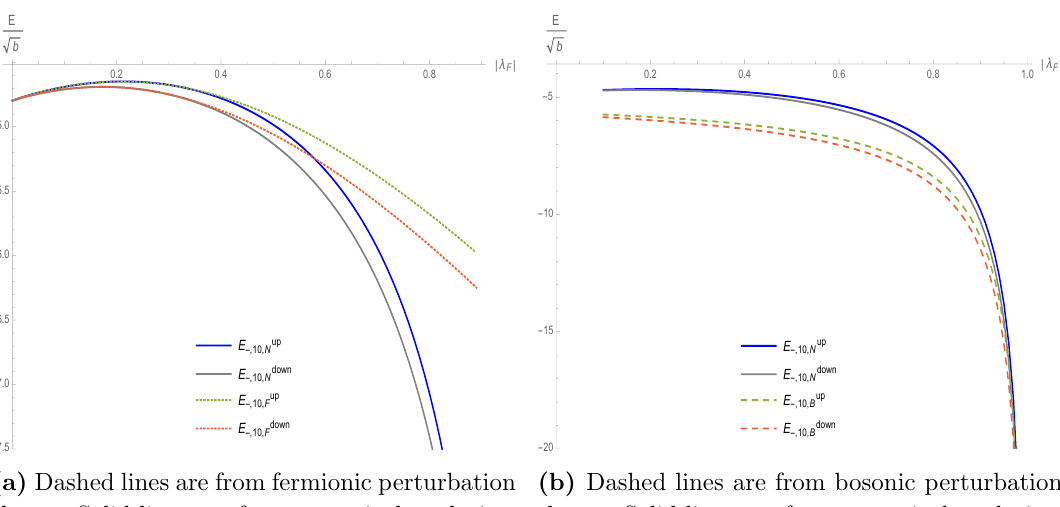
(a) Dashed lines are from fermionic perturbation (b) Dashed lines are from bosonic perturbation theory. Solid lines are from numerical analysis. theory. Solid lines are from numerical analysis. Figure 4. Critical chemical potentials for the M = 10 negative energy band as a function of (cid:21) F p for sgn(b (cid:21) F ) = 1 at m cri = (cid:0) j b j B